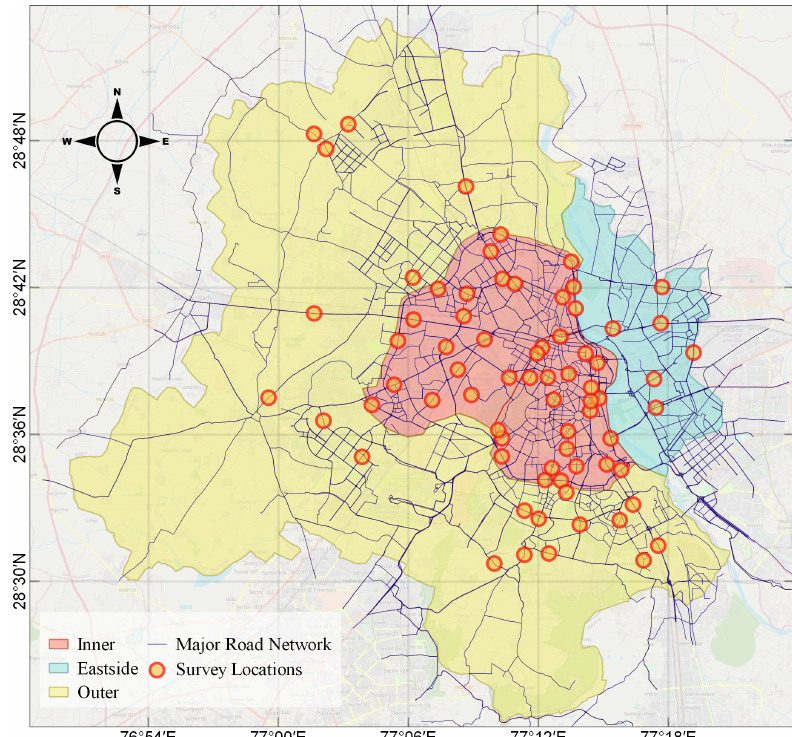
Figure 1. Map showing the study domain with TRIPP survey locations and the major road links over Delhi. The domain is segregated to three regions (Inner, East side and Outer) shown in different colours. The background map is from https://www.openstreetmap.org/ (last access: 1 December 2022); © OpenStreetMap contributors 2022. Distributed under the Open Data Commons Open Database License (ODbL)